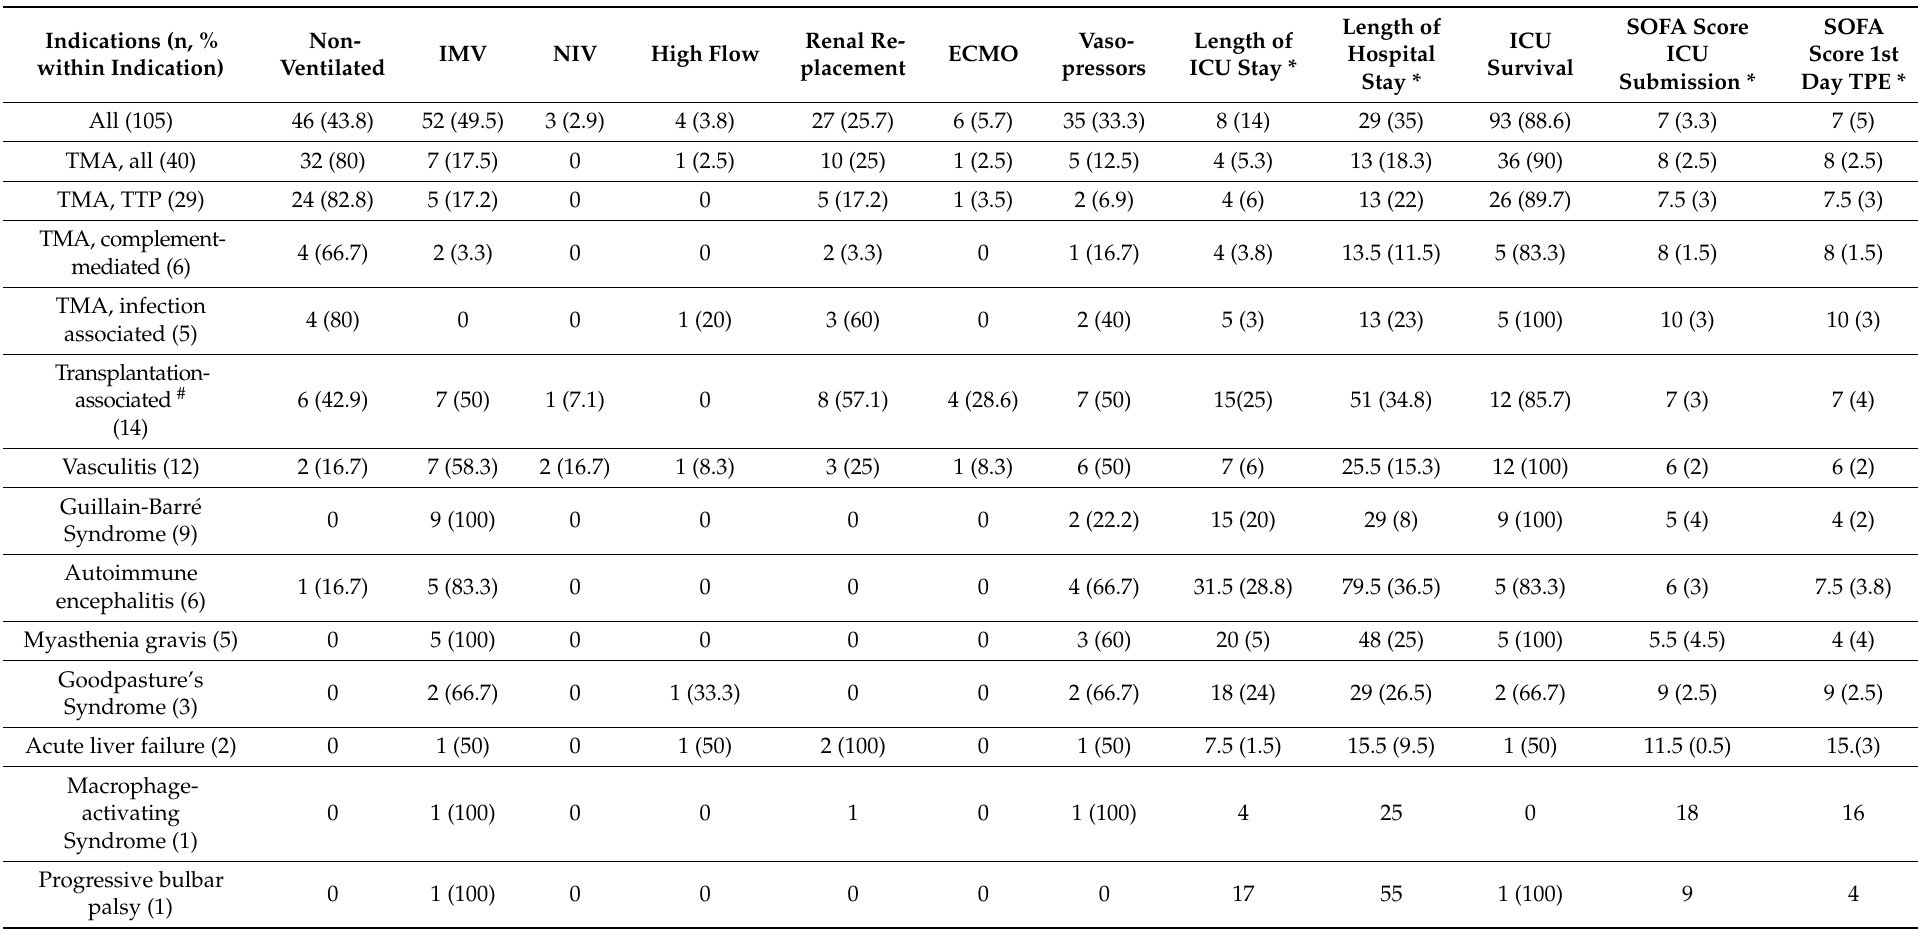
Table 4. Indications with ICU specifics. Data are shown as patients per category and percentage of the total population. Abbreviations: TTP—Thrombotic thrombocytopenic purpura, TMA—Thrombotic microangiopathy, SOFA score—Sequential Organ Failure Assessment score, ICU—intensive care unit, ECMO— extracorporeal membrane oxygenation, TPE—plasma exchange, SD—standard deviation. * Data expressed as median and interquartile range #